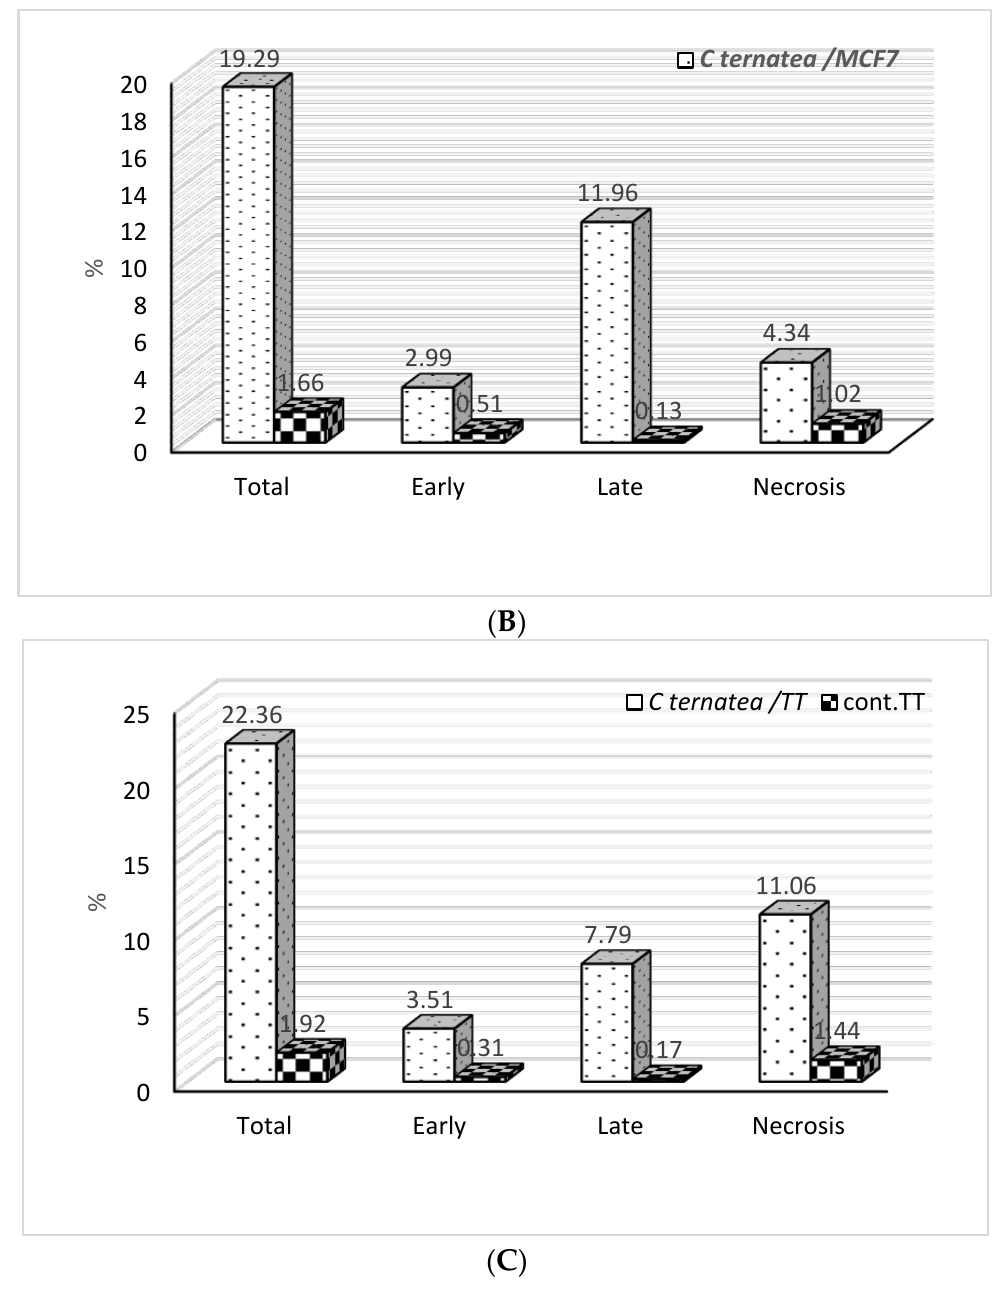
Figure 3. Impacts of IC50 concentrations of C. ternatea on the stimulation of apoptosis along with ( A ) HCT116, ( B ) MCF-7, and ( C ) TT cell lines.